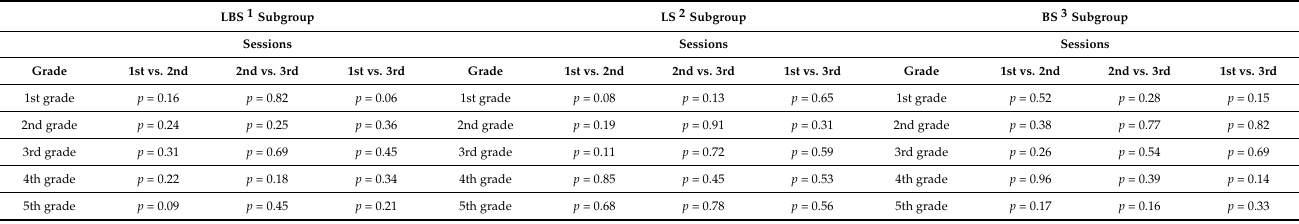
Figure 1. Results for gross and fine motor proficiency for the LBS subgroup. The scores are reported as a normalized mean of the BBT and the TGMD-3 per grade (dots) and standard deviations (lines). Performances gradually improved with age for both gross and fine motor skills, but this overall improvement was more evident between the 1st and 4th grade, 1st and 5th grade, 2nd and 4th grade, and 2nd and 5th grade, as evidenced by the significant difference ( p < 0.001) in general motor proficiency (see Tables 11 and 14). Conversely, no significant differences were found in both gross and fine motor performances as the sessions progressed (see Tables 16 and 17). Table 16. Statistical significance ( p -value) of the changes in gross motor performance during the